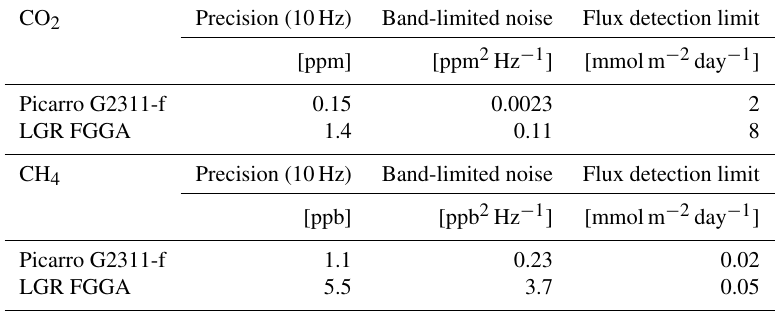
Table 1. Performance of the Picarro G2311-f and LGR FGGA at measuring CO 2 and CH 4 fluxes by eddy covariance. Precision refers to observed noise at 10Hz. Band-limited noise is averaged between 1 and 5Hz from the mean variance spectra. Flux detection limit is estimated at a wind speed of 10ms − 1 in a neutral atmosphere (hourly average). The FGGA band-limited noise and detection limit correspond to when the ring-down time was optimal and the instrument sensitivity at its